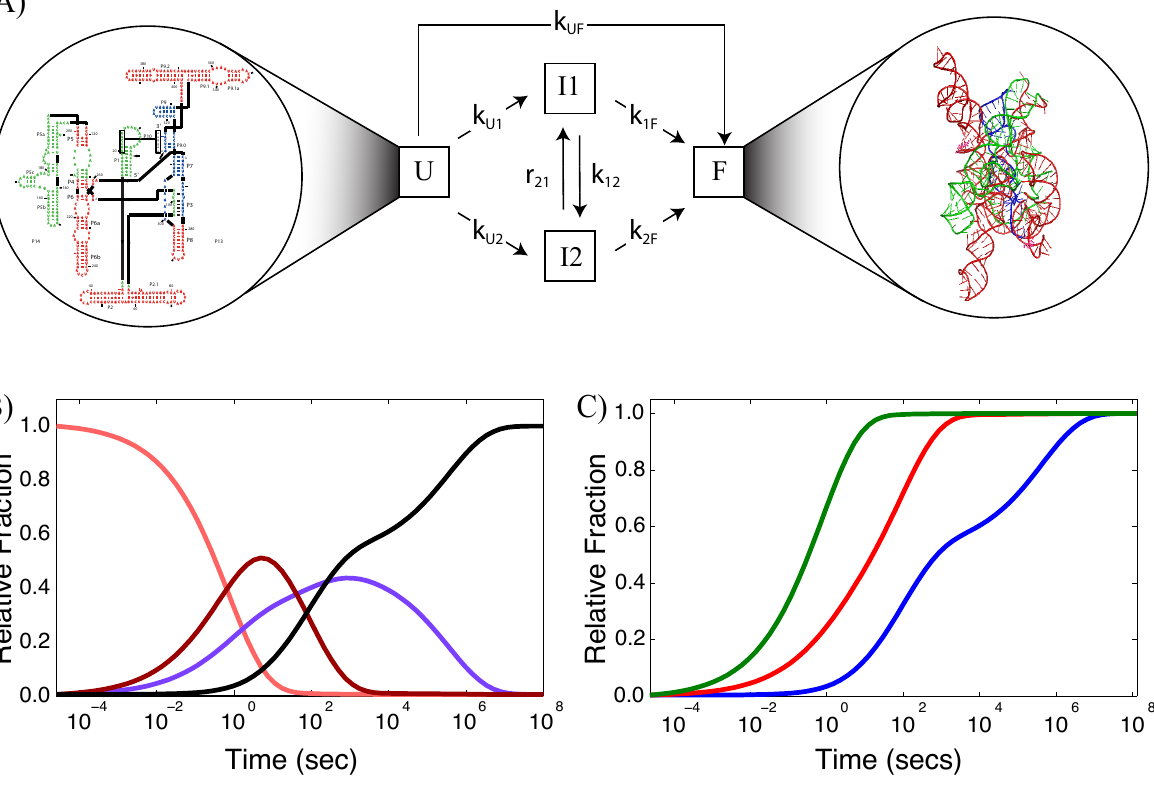
2 ( t ) ) for P . The green 2